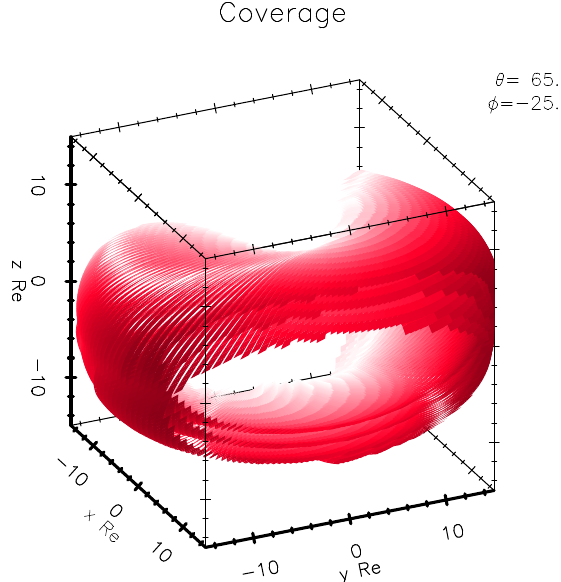
Fig. 1. Cluster orbital coverage of the magnetosheath from January 2001 to May 2004. The spacecraft position from the magnetopause are indicated in red-white shading. Parts of the orbital trajectory lying closest to the magnetopause are indicated in white; those lying further out are indicated in red.